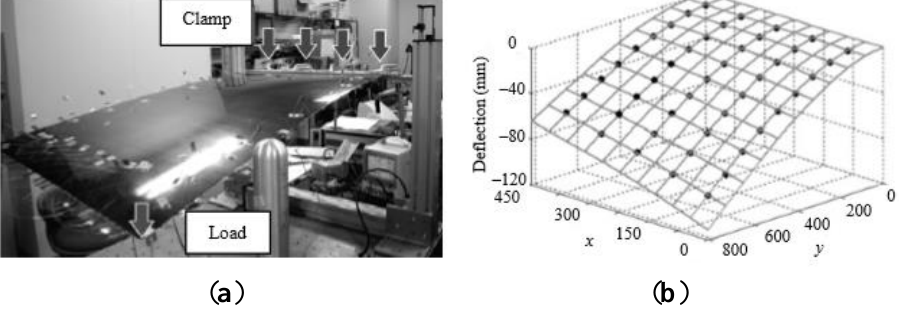
Figure 23. Photo of the cantilever plate experiment ( a ); reconstructed deflection shape of the plate ( b ) [166].